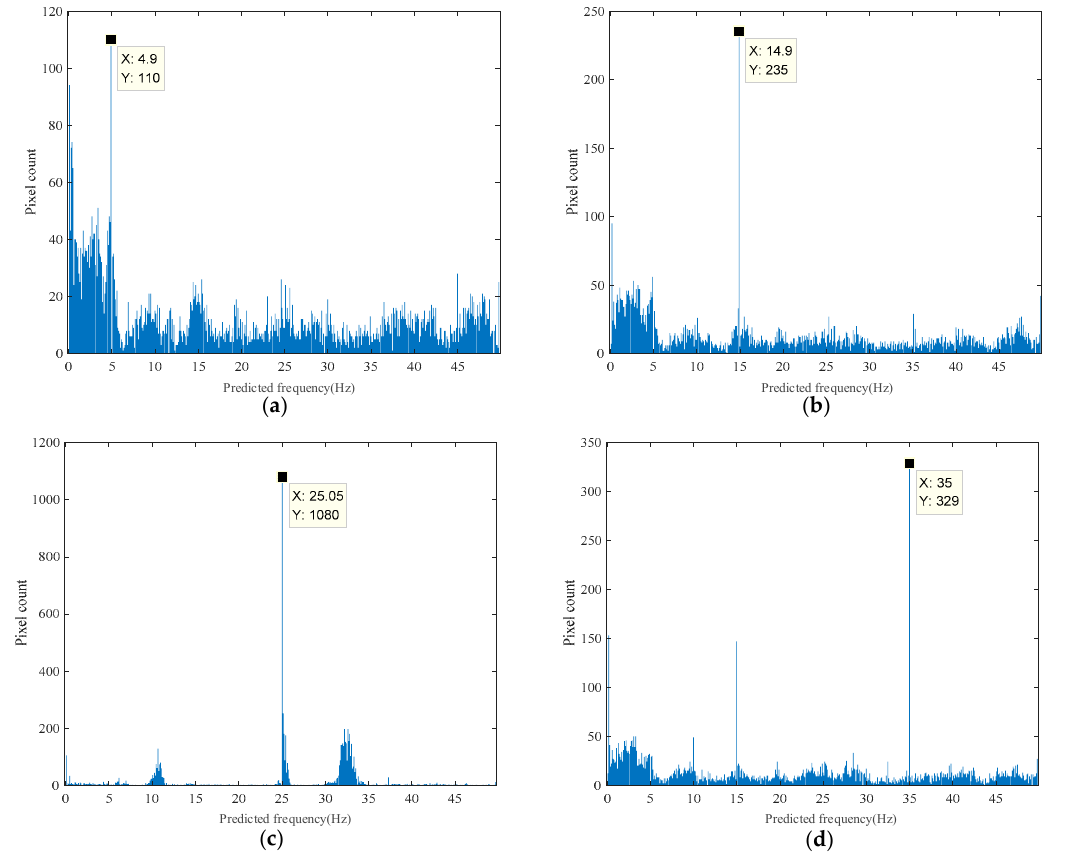
Figure 7. Four representative results of histogram of the predicted frequency distribution: ( a ) 5 Hz excitation result; ( b ) 15 Hz excitation result; ( c ) 25 Hz excitation result; ( d ) 35 Hz excitation result.